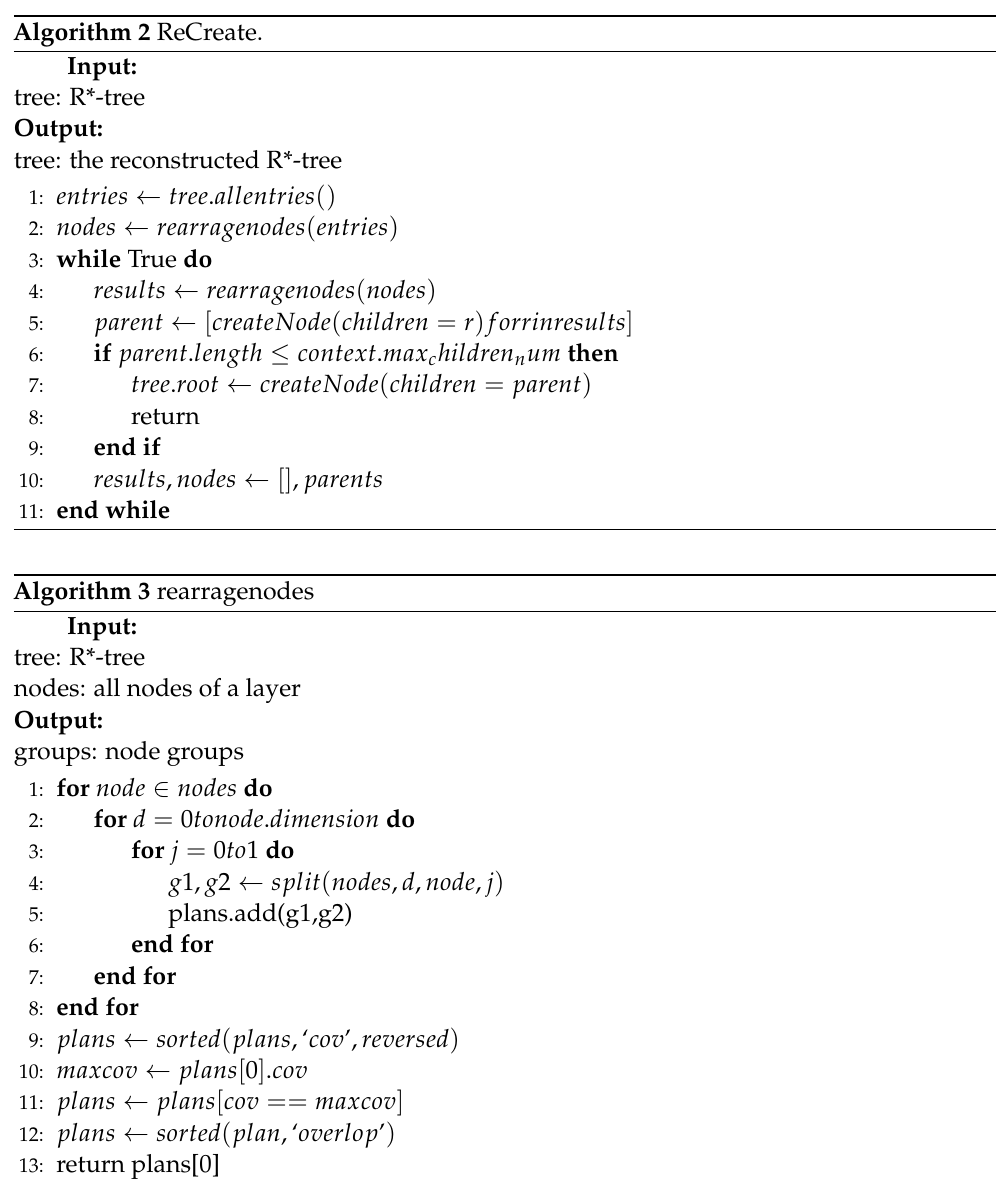
Algorithm 2 ReCreate.